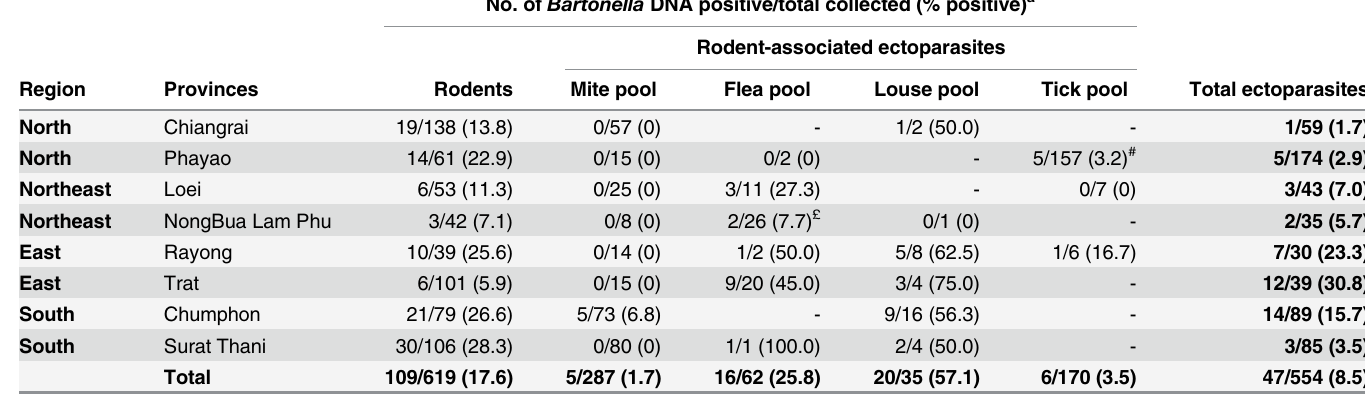
Table 2. Prevalence of Bartonella DNA among wild-caught rodents and their associated ectoparasites collected from different regions and prov- inces in Thailand, 2012 – 2013. No. of Bartonella DNA positive/total collected (% positive) a Rodent-associated